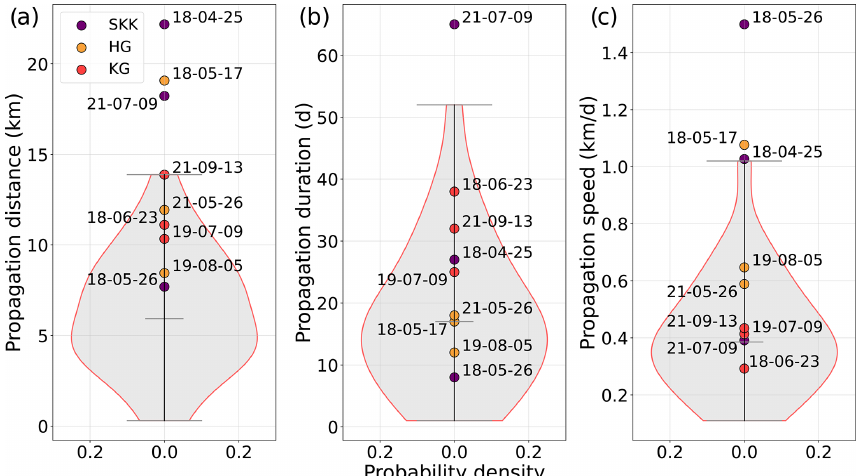
Figure 6. (a) Propagation distance, (b) duration and (c) speed of 29 IMW episodes detected at KG, presented as mirrored probability density functions, also known as violin plots (gray areas). The central tick corresponds to the median and the upper and lower ones to the distribution’s extrema. The second IMW episode detected in 2021 (Fig. 5) has been removed from (c) due to its anomalously high propagation speed (3.4km in 1d), which would have highly altered the representation of the probability density function. This episode nevertheless still contributes to the variable’s statistics. The characteristics of each set of three IMW episodes analyzed at KG, HG and SKK and presented in Figs. 2 to 4 are shown as red, orange and purple dots, respectively.